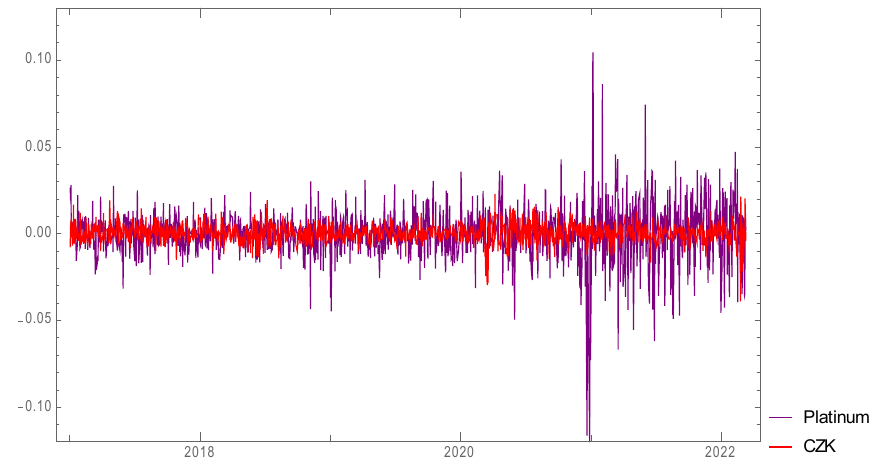
Figure 3. Differences of changes in CZK and platinum prices.